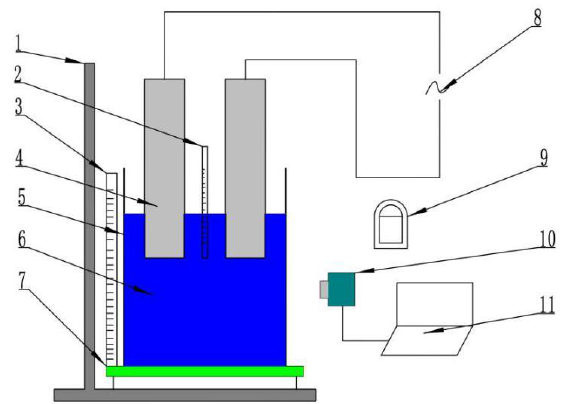
Figure 4. Schematic diagram of the physical simulation apparatus. 1—insulation support; 2—